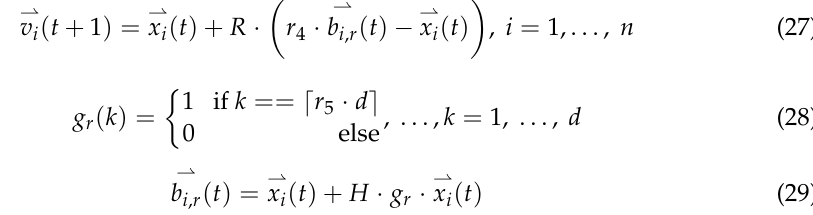
A >1 A <1 Figure 6. Schematic diagram of probability calculation of detour food searching. 5. Case Studies In this section, ARO was applied in several PV cells and SOFC models for unknown parameter identi fi cation in the MATLAB/SIMULINK testing environment for perfor- mance validation. In particular, the DDM benchmark PV cell model was used for PV cell validation. For SOFC parameter identi fi cation, the electrochemical model was used for veri fi cation. All case studies are undertaken by Matlab 2022a through a personal computer with IntelR CoreTMi7 CPU at 2.0 GHz and 32 GB of RAM (Santa Clara, CA, USA). 5.1. PV Cell Model Parameter Identi fi cation 5.1.1. Design of ARO for PV Cell Parameter Identi fi cation In order to achieve reliable optimization, the optimization variable 𝑥 (cid:3037) is limited to the upper limit 𝑥 (cid:3037)(cid:2923)(cid:2911)(cid:2934) and lower limit 𝑥 (cid:3037)(cid:2923)(cid:2919)(cid:2924) as follows: 𝑥 (cid:3037)(cid:2923)(cid:2919)(cid:2924) (cid:3409) 𝑥 (cid:3037) (cid:3409) 𝑥 (cid:3037)(cid:2923)(cid:2911)(cid:2934) , 𝑗 (cid:3404) 1,2…, 𝐽 (31) where J represents the optimizing variables number.